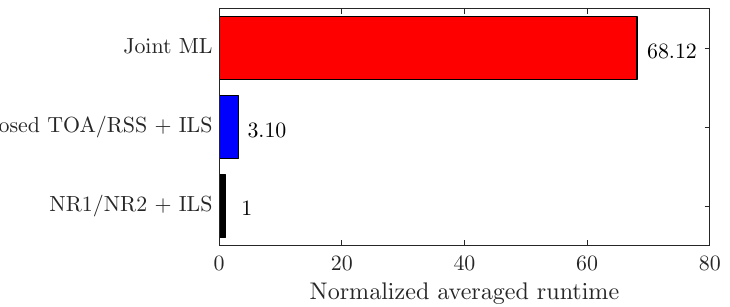
Figure 3. Averaged runtimes of the considered localization